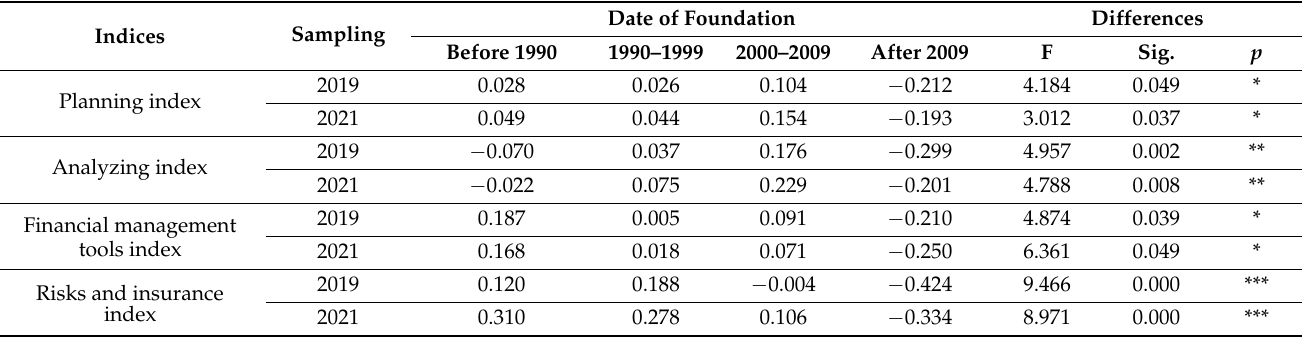
Table 4. Development of averages of normalized indices by age of